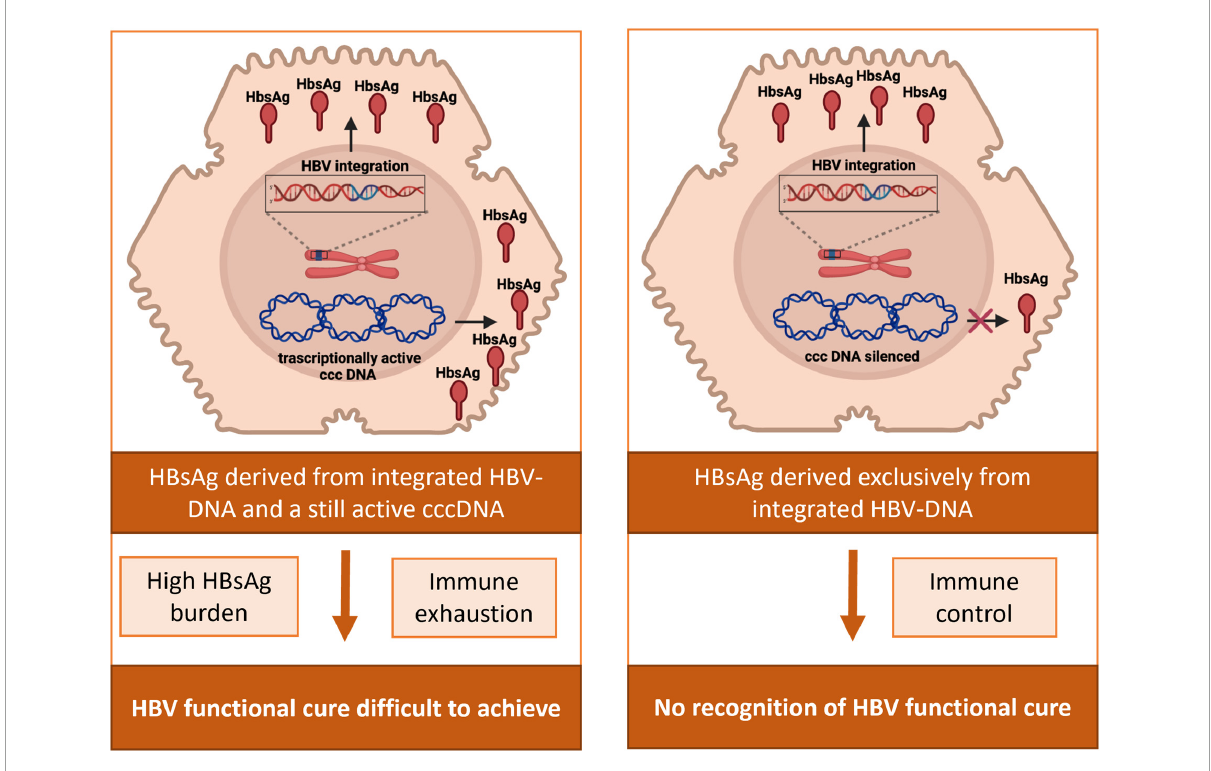
FIGURE4 Impact of HBV-DNA integration in the achievement and assessment of HBV functional cure. In patients with an active HBV reservoir, HBsAg can derive from the transcriptional activity of cccDNA and from HBV-integrated DNA. HBsAg from integrated HBV-DNA can consequently contribute to the elevated burden of viral antigens and the subsequent exhaustion of anti-HBV immune response, potentially jeopardizing the achievement of HBV functional cure. In patients with a silenced HBV reservoir, HBsAg in serum can still be present deriving exclusively from integrated HBs-encoding regions, thus hampering the proper recognition of the achievement of HBV functional